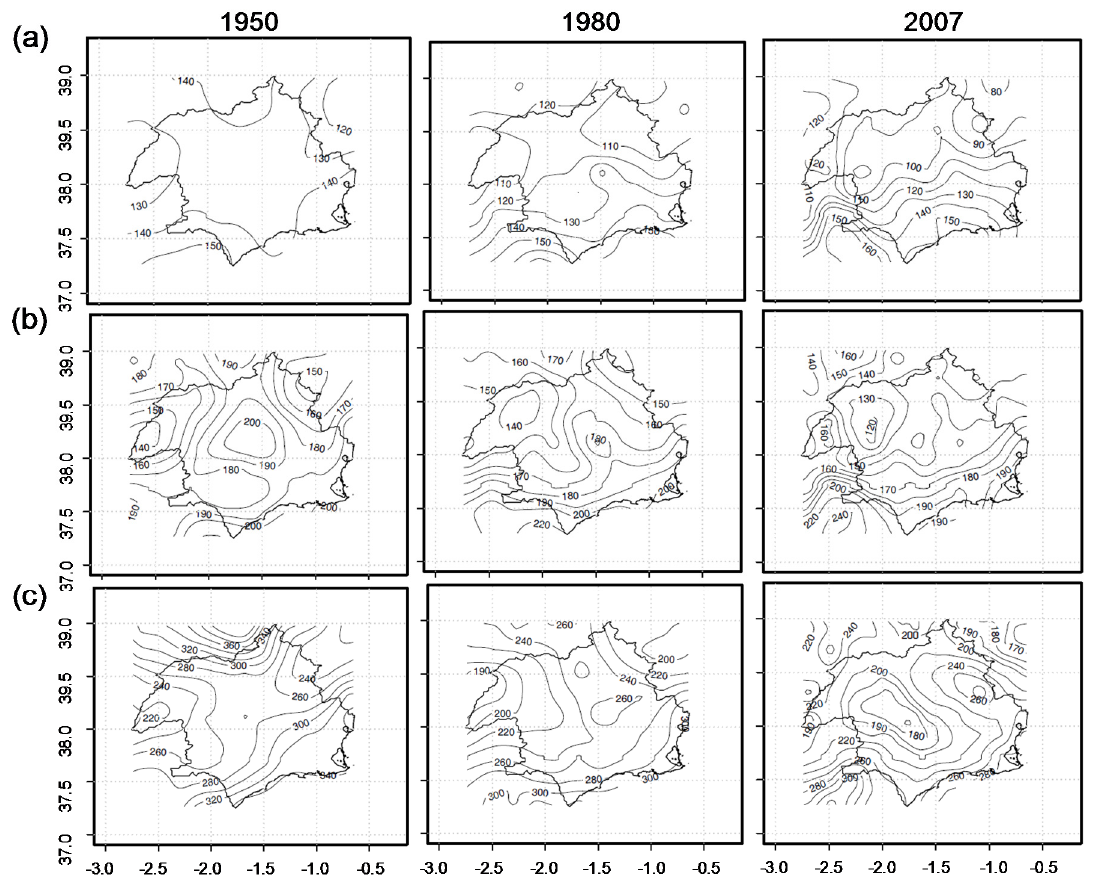
Figure 7. Spatial distributions of σ (days) of MDSL, for years 1950, 1980, and 2007, considering several thresholds: ( a ) 1 mm/day; ( b ) 5 mm/day; ( c ) 10 mm/day.